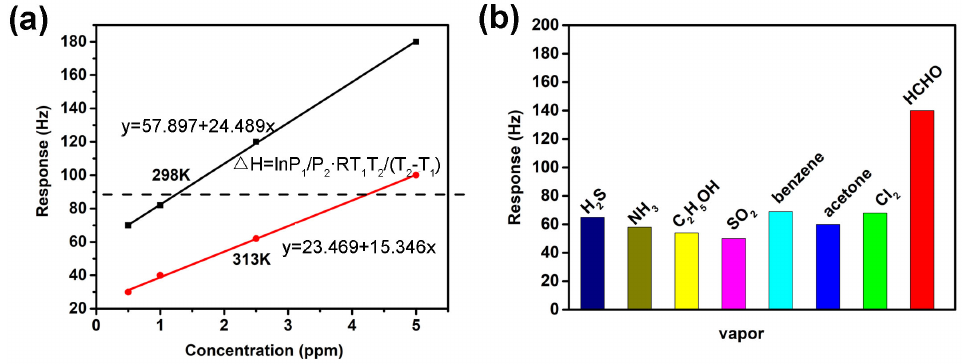
Figure 11. ( a ) Based on the experimental results in Figure 10a,c, two isotherms were plotted to calculate the adsorption heat ( ∆ H), ( b ) response of PANI-CNC-based QCM to different vapors in 3 ppm (25 ◦